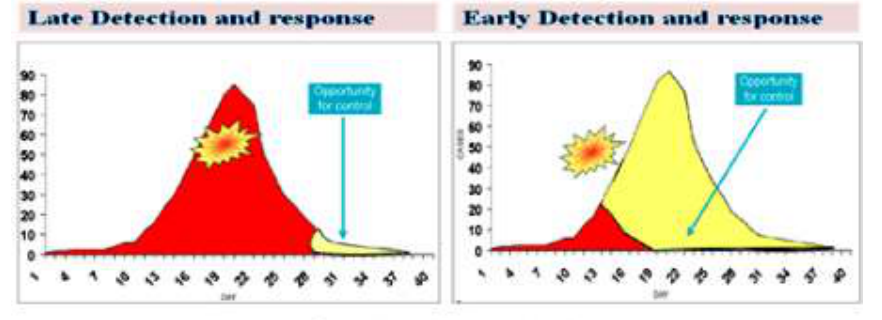
Figure-1. Early and late detection of disease and opportunity to control